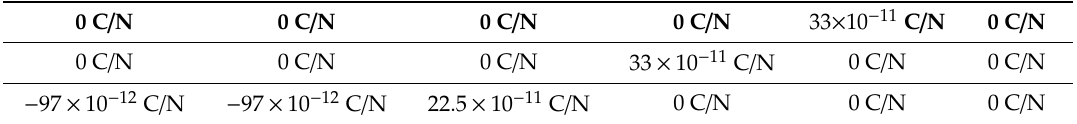
Table A1. The piezoelectric strain constant matrix of the PZT-8.